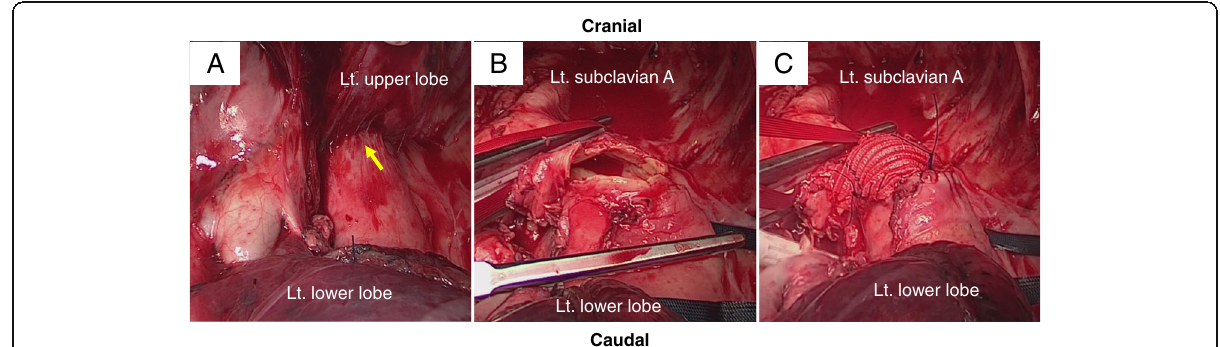
Fig. 2 Intraoperative findings. a Macroscopic inspection strongly indicating aortic invasion in the periphery of the third branch (arrow). b The invasive part of the descending aortic wall is resected under partial extracorporeal circulation. c Patch closure of the aortic defect is